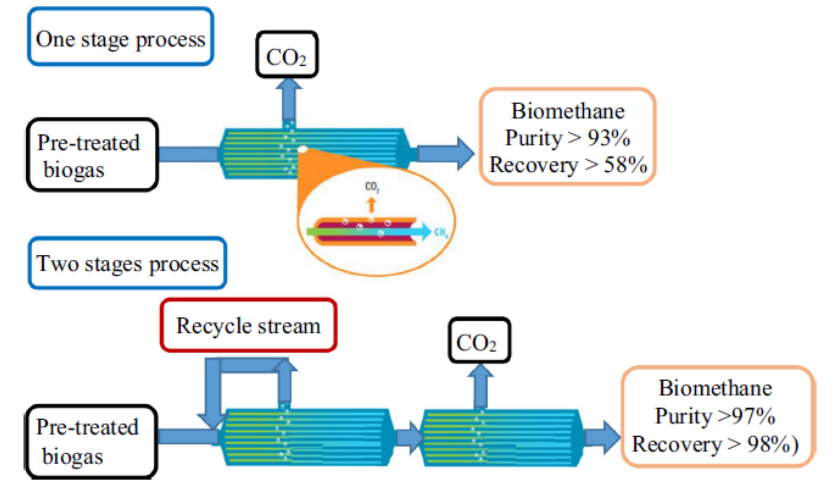
Figure 11. Scheme of the membrane separation process [93] .